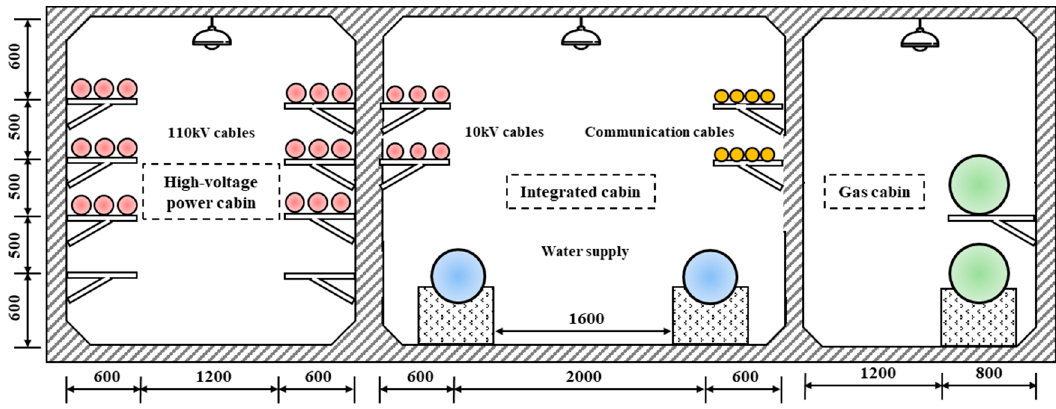
Table 2. Engineering parameters of traditional buried pipelines. Figure 3. Cross-sectional view of utility tunnel in Taopu Science and Technology Intelligence City. Table 1. Engineering parameters of UUT-laying pipelines.